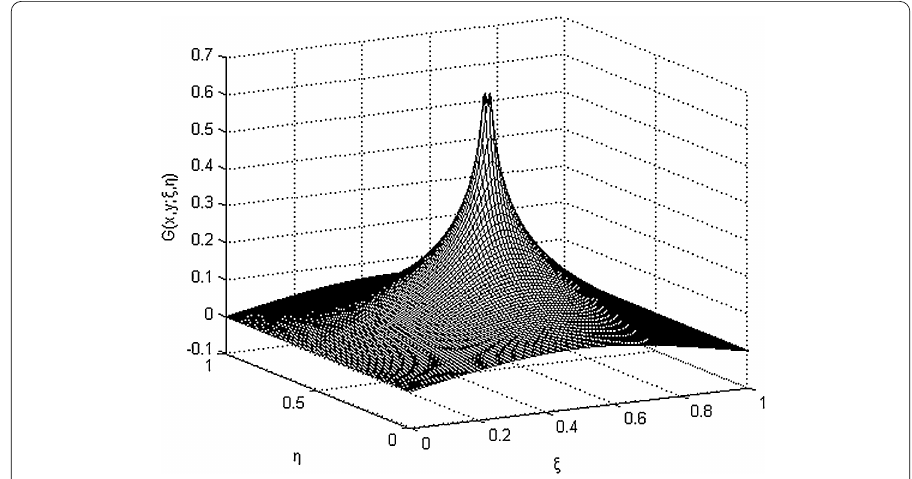
Figure 3 Plot of the Green’s function G ( x , y ; ξ , η ) on rectangular